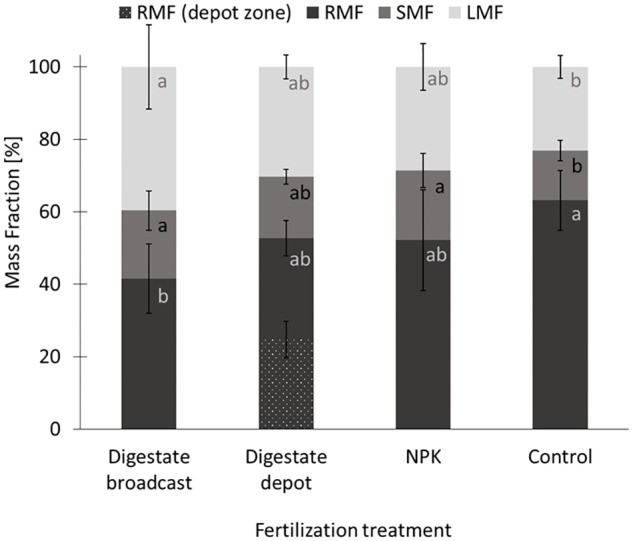
Mass fractions of S. hermaphrodita grown in rhizotrons for 90 days. RMF, root mass fraction; depot zone, zone in a 6 cm radius around the digestate depot; SMF, stem mass fraction; LMF, leaf mass fraction. All fertilization treatments were adjusted to a digestate application of 40 t ha−1. Digestate broadcast: homogeneously incorporated in the top 20 cm; Digestate depot: localized digestate application; NPK: homogeneously incorporated in the top 20 cm; Control: no fertilization; n = 8 replicates for each treatment. Values labeled with the same letter are not significantly different at p < 0.05. Error bars indicate the standard error.